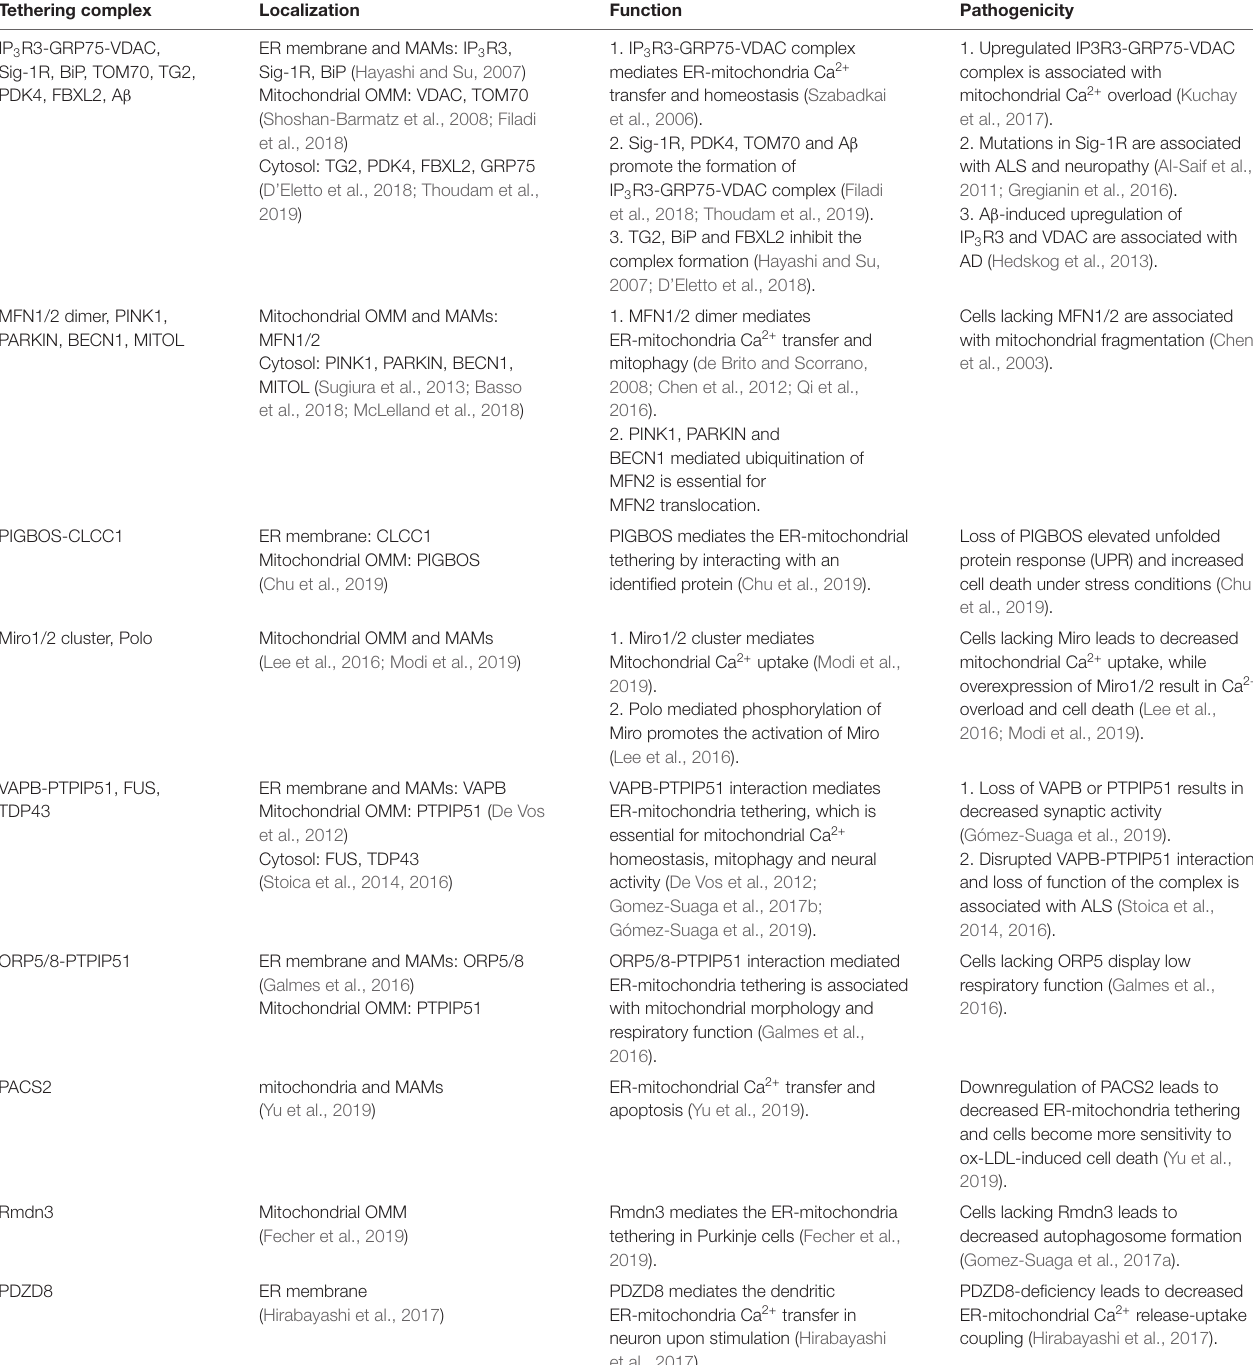
TABLE 1 | The molecular determinant for endoplasmic reticulum (ER)-mitochondria tethering in mammal cell. Tethering